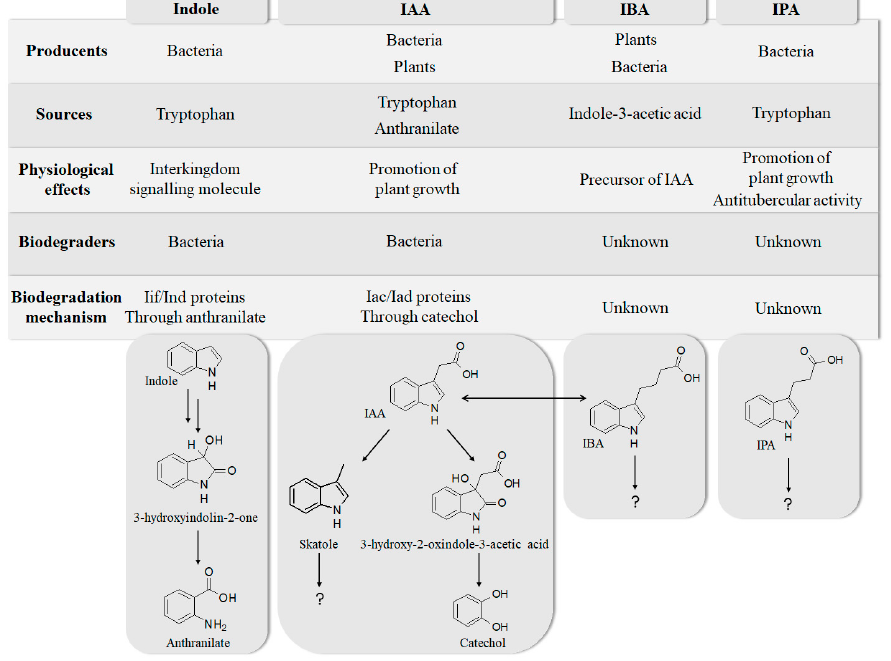
Figure 1 . Metabolism of biologically relevant derivatives of indole. Figure 1. Metabolism of biologically relevant derivatives of